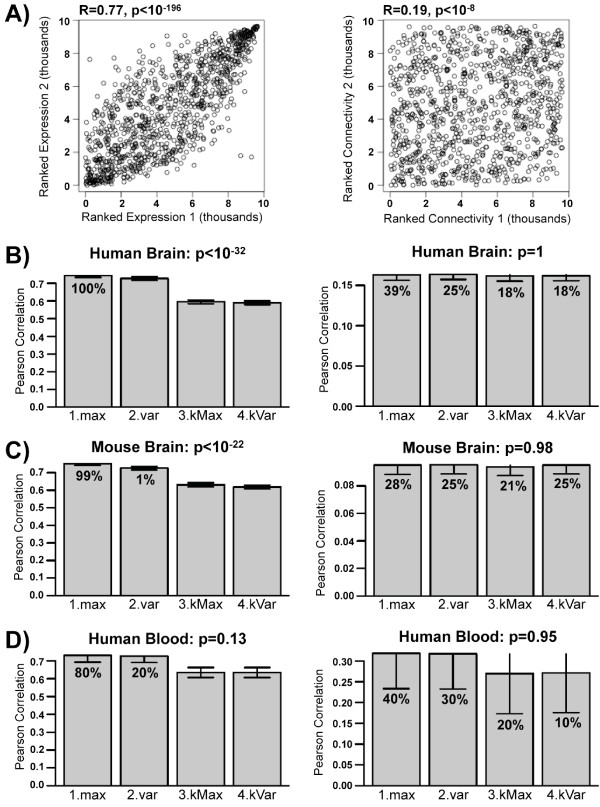
When collapsing probes to genes, 1.max is usually the optimal collapsing strategy to choose. A) A typical example of ranked expression (left column) and ranked connectivity (right column) correlation between two data sets. Each dot represents a gene in common between data sets, with the x and y axes represented that gene's ranked expression or connectivity in data sets 1 and 2, respectively. B-D) Across several studies in human brain (B), mouse brain (C), and human blood (D) the MaxMean (1.max) parameter generally produces better ranked expression correlations (left column) than maxVariance (2.var). For both MaxMean and maxVariance, use of connectivityBasedCollapsing (3.kMax and 4.kVar) decreases the between-study correlations. Similar results hold, to a lesser extent, with connectivity correlations (right column). Y-axes correspond to the average expression and connectivity correlation between data sets. Error bars represent standard error. Percentages indicate the percent of assessments in which the relevant strategy had the highest overall between-set correlation.